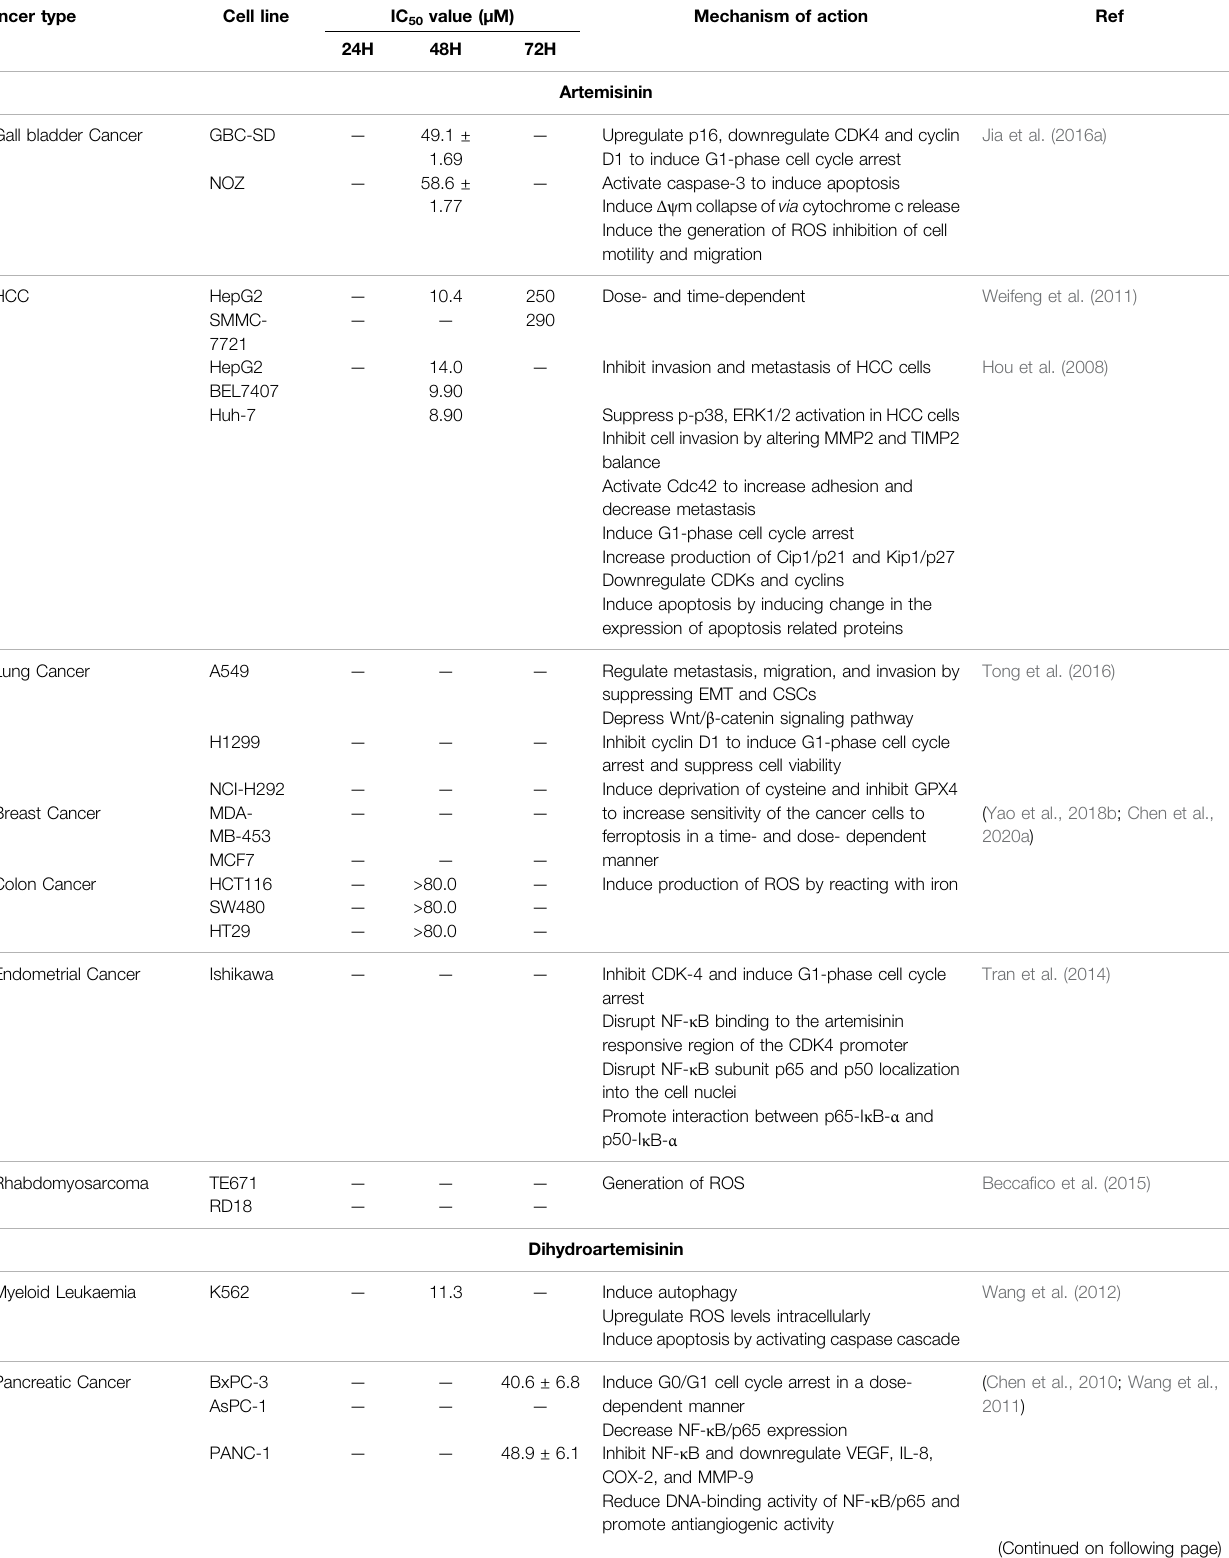
TABLE 1 | IC 50 and Mechanisms of artemisinins in vitro . Cancer type